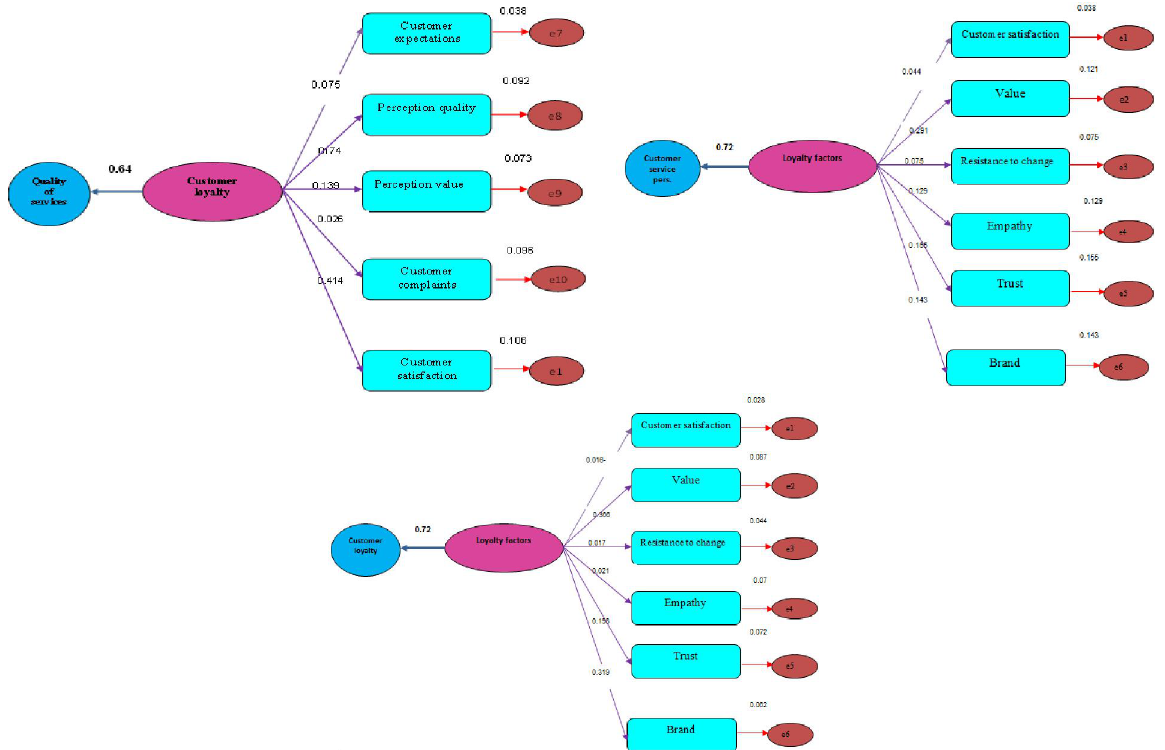
Fig. 1. The results of standard values of path analysis